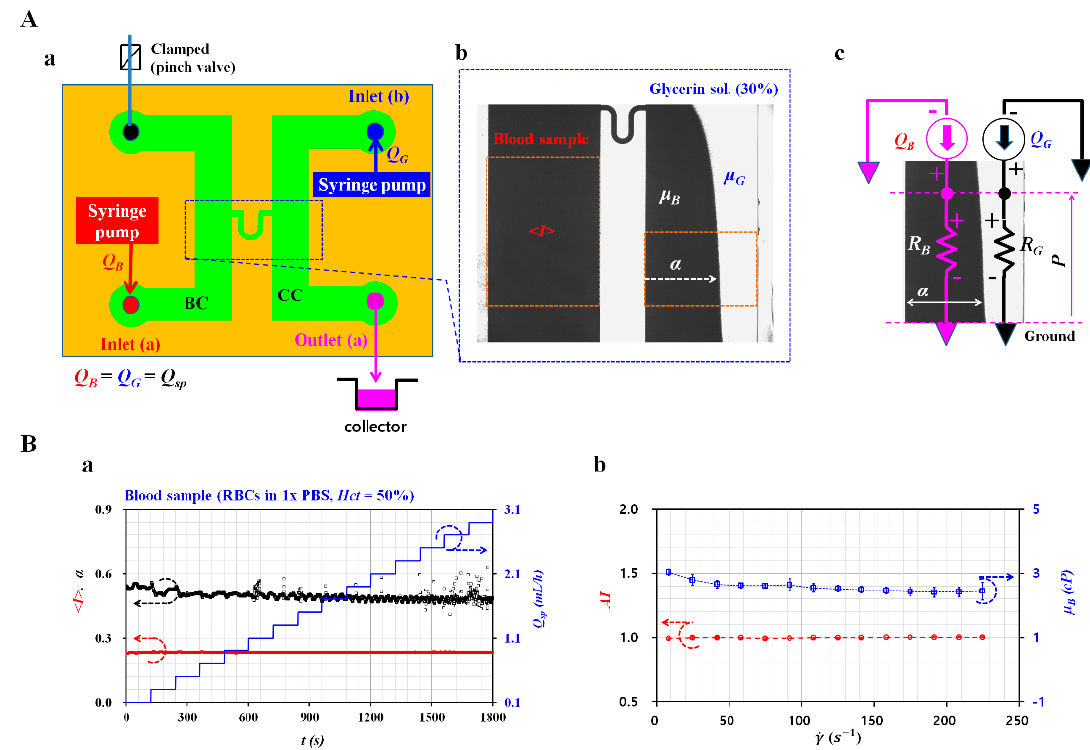
Figure 7. Quantification of RBC aggregation ( AI) and blood viscosity ( µ B ) in microfluidic environment. ( A ) Simultaneous measurement of AI and µ B with microfluidic device. ( a ) Schematic of experimental setup for measuring AI and µ B . ( b ) Quantification of microscopic image intensity ( < I > ) in blood channel and interface ( α ) in coflowing channel. ( c ) Discrete fluidic circuit model for blood viscosity in coflowing channel. ( B ) Quantification of AI and µ B for normal blood sample (normal RBCs in 1x PBS, Hct = 50%). ( a ) Variations of < I > , α , and Q sp with an elapse of time. ( b ) Variations of AI and µ B over shear rate.